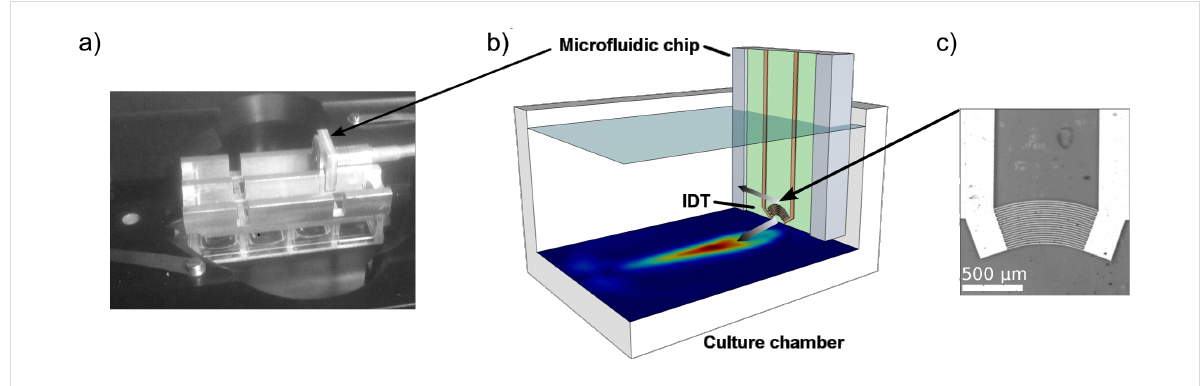
Figure 2: a) Photograph of the sample system on a microscope stage. The chip is mounted onto a culture slide by a metal frame. b) Sketch of the chip. A focusing interdigital transducer induces acoustic streaming with the main flow component pointing downwards, incident at the bottom in an angle of approximately 23° and inducing shear stress on the surface. c) Micrograph of the